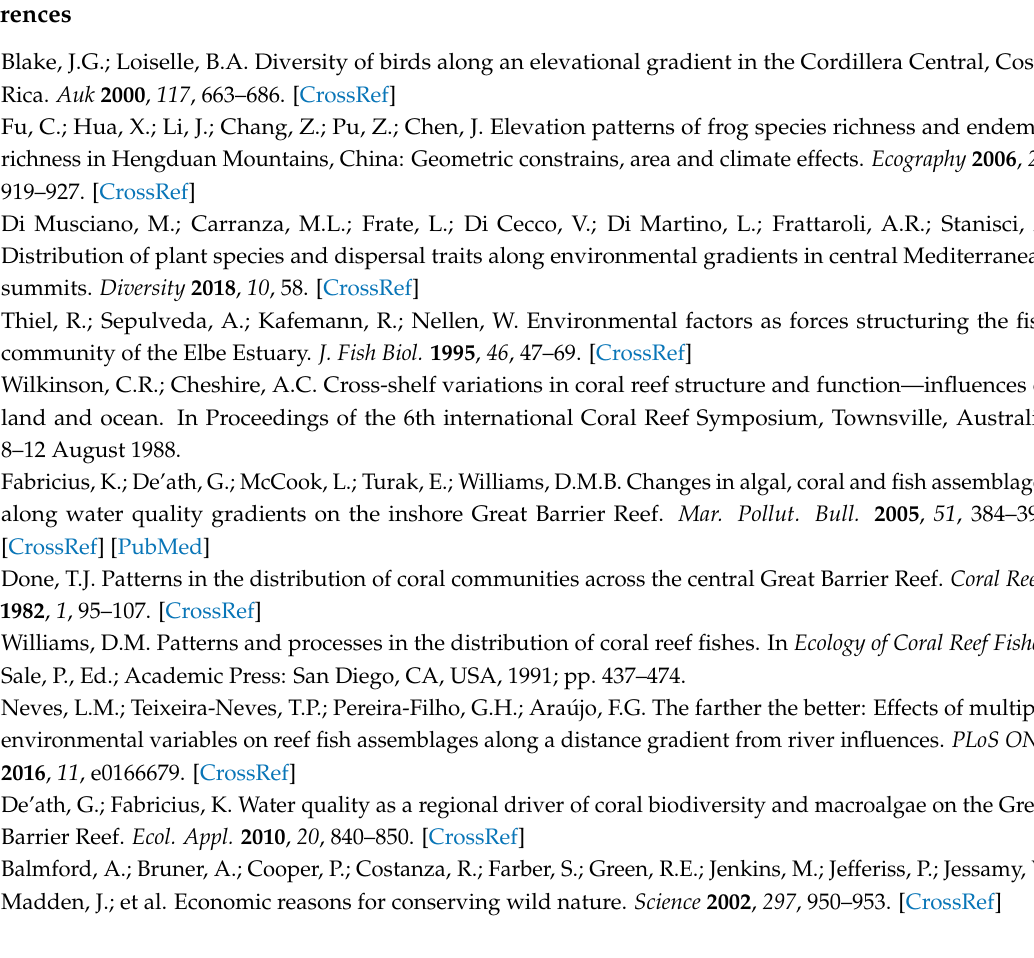
Table S1: Fish traits assigned to surveyed species. Trait classification based on published literature (Green and Bellwood 2009 [1]; Froese and Pauly 2018 [2]; Mouillot et al. 2013 [3]). Schooling trait categories abbreviated as follows: Small groups (SmallG); medium groups (MedG); large groups (LargeG). Table S2: Two-way nested PERMANOVA pairwise comparisons with Monte Carlo sampling estimates of taxonomic composition of herbivorous fish among shelf position and between years. Comparisons based on Bray-Curtis similarities of fourth root transformed data (shelf position and year, fixed factors; site random factor nested in shelf position; 9999 iterations). Herbivorous fish species consistently contributing to average similarity within assemblages across the shelf (grey boxes) in each year are listed (one-way SIMPER; sim/SD, dissim/SD > 2). Multivariate dispersion analysis (MVDISP) results shown with an index of multivariate dispersion (IMD).; Table S3: Pairwise comparisons (with lower and upper 95% confidence intervals: CI) of linear mixed effects models of variation in cross-shelf benthic composition and herbivorous fish assemblage structure in 2008/9 and